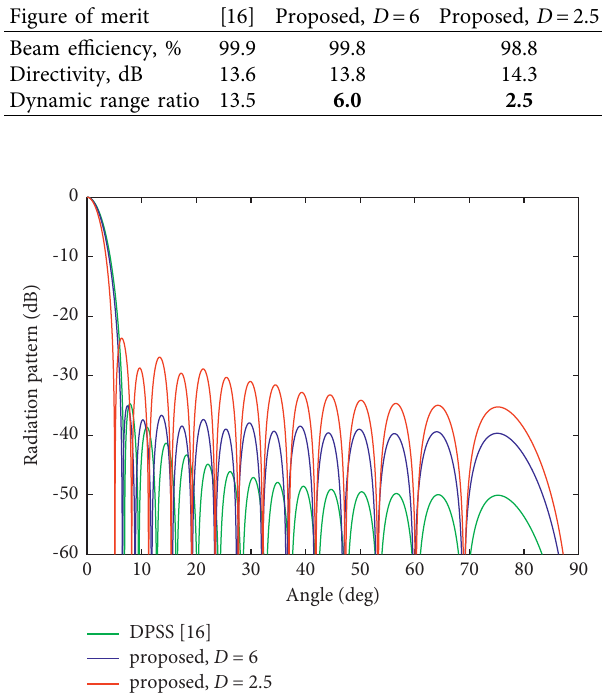
Figure 11: Radiation patterns of proposed pencil beam arrays with minimum SLP and DRR constrained to D � 6 and D � 2.5, com- pared to array with maximum efciency [16]. All arrays have 30 elements and beamwidth of 12 ° . Table 8: Optimum coefcients of proposed array from Table 6, obtained for D � 2.